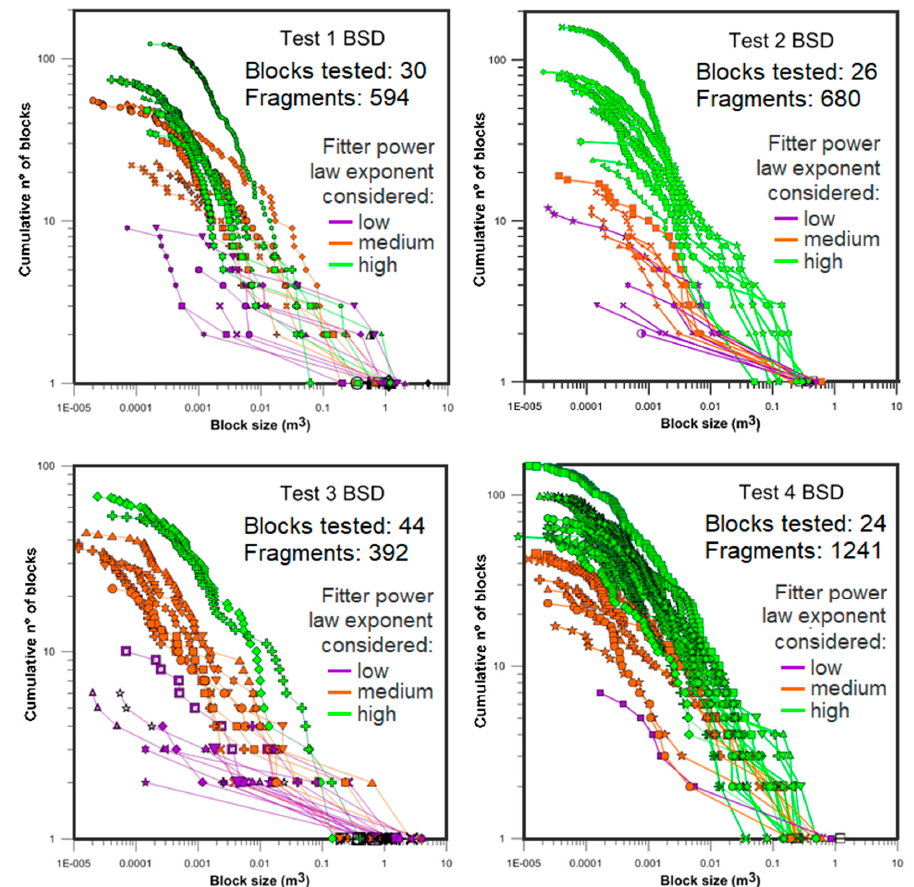
Figure 15. Block size distributions of all the fragments measured on each block dropped, arranged by test site. The distributions are colored with: low (purple), medium (orange) and high (green) value of the exponent of the fitted power law.